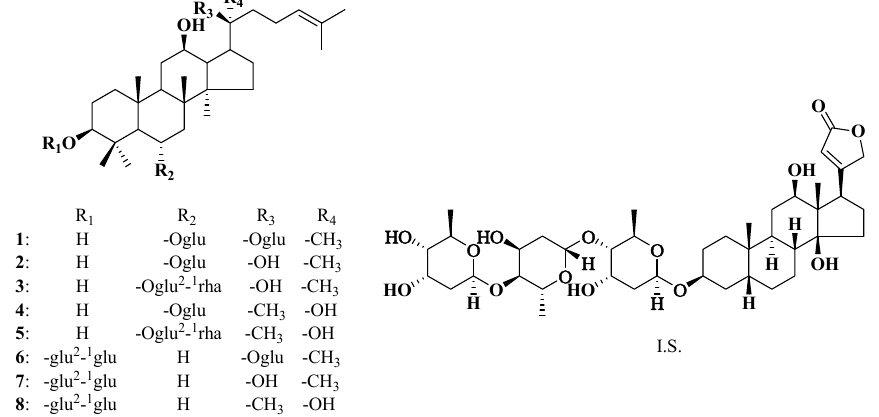
Figure 1. Chemical structures of eight ginsenosides [ 1 , ginsenoside Rg 1 ; 2 , 20( S )-ginsenoside Rh 1 ; 3 , 20( S )-ginsenoside Rg 2 ; 4 , 20( R )-ginsenoside Rh 1 ; 5 , 20( R )-ginsenoside Rg 2 ; 6 , ginsenoside Rd; 7 , 20( S )-ginsenoside Rg 3 ; 8 , 20( R )-ginsenoside Rg 3 ] and I.S. (digoxin).